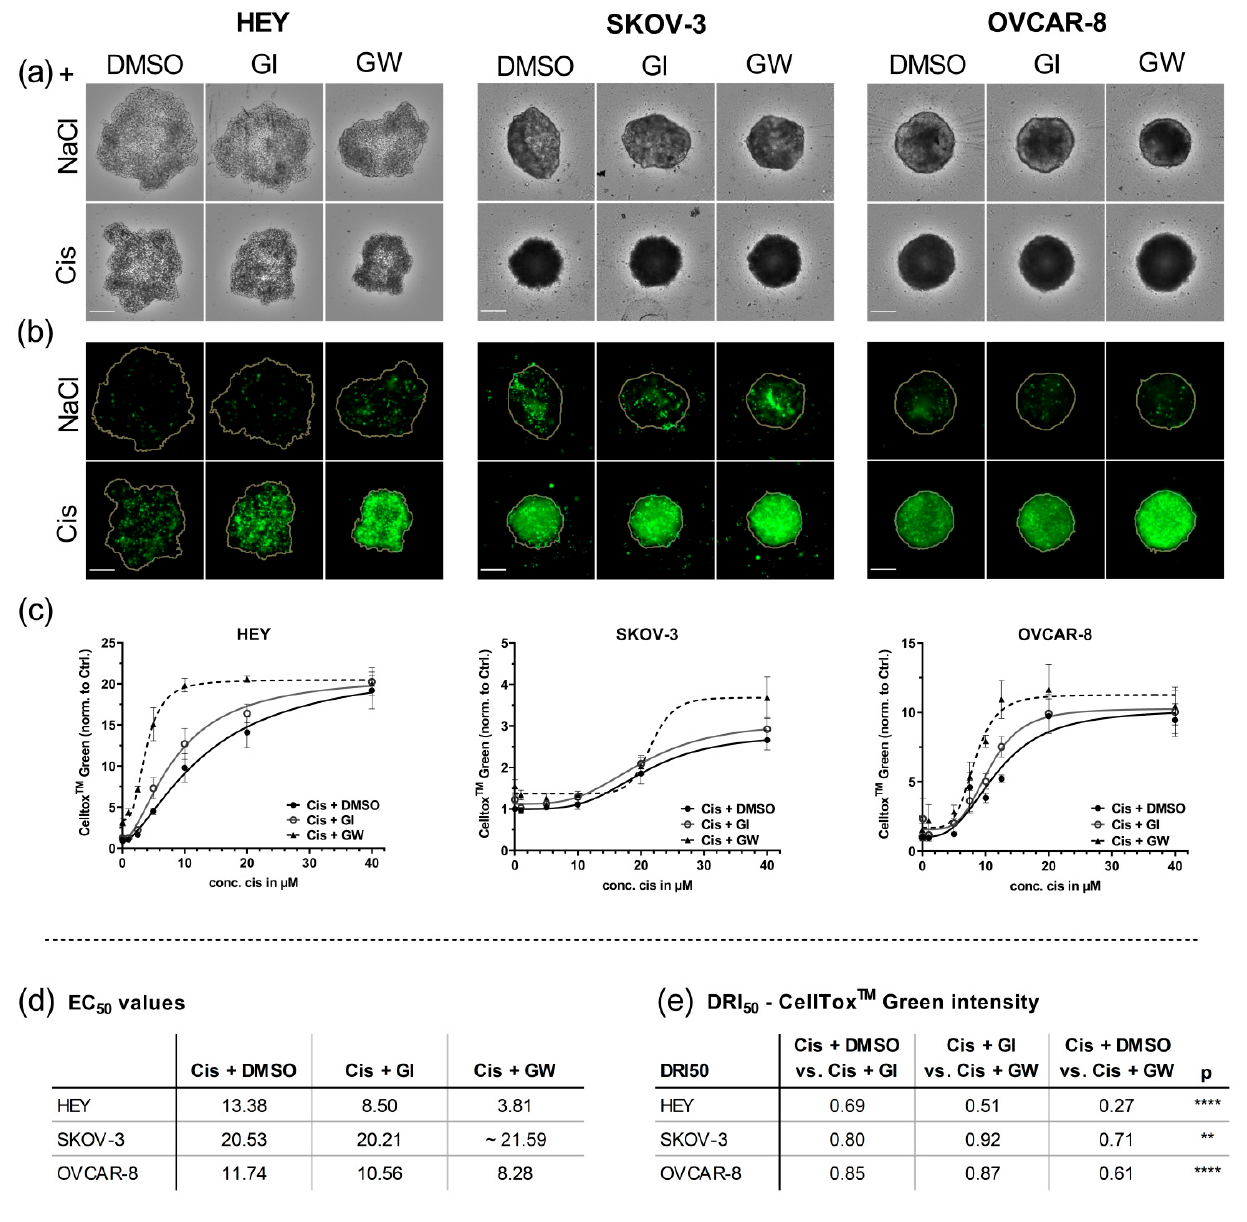
Figure 5. Combined cytotoxic effects of GW280264X and cisplatin in OvCa cell line spheroids can be visualized and quantified using automated imaging. OvCa cell lines were cultured for 4 days in ULA plates for formation of spheroids and treated with the indicated concentrations of cisplatin (Cis) and NaCl. ADAM17 activity was inhibited using GW280264X (GW) and ADAM10 by GI254023X (GI). DMSO was used as a solvent control. At 48 h after treatment, the spheroids were imaged using NYONE ® Scientific. ( a ) Representative brightfield (BF) images 48 h after treatment. Displayed are concentrations achieving the strongest combinatorial effects (HEY: 5 µ M cisplatin; SKOV-3: 40 µ M cisplatin, OVCAR-8: 10 µ M cisplatin.). ( b ) Corresponding CellTox TM Green (CTG) images. Orange line indicates spheroid area as determined in the BF image by the spheroid quantification (1F) application of YT ® -Software. The strongest CTG staining was observed with the combination of cisplatin and GW280264X (lower panel, right image). Objective: 4 × , Scale: 250 µ m. ( c ) Normalized CTG intensities of at least three biological replicates demonstrate the combined effect of GW280264X and cisplatin. The mean ± SEM is displayed. Curve fitting was performed using GraphPad Prism 9. Based on the Shapiro–Wilk normality test, EC 50 values of biological replicates were analyzed by ANOVA following Tukey ´ s multiple comparison test. ( d ) EC 50 values of CTG; ( e ) drug reduction index (DRI 50 ) at 50% effectiveness. Synergistic effect (DRI 50 < 1), additive effect (DRI 50 = 1), and antagonistic effect (DRI 50 > 1). ** p < 0.01, **** p < 0.0001.